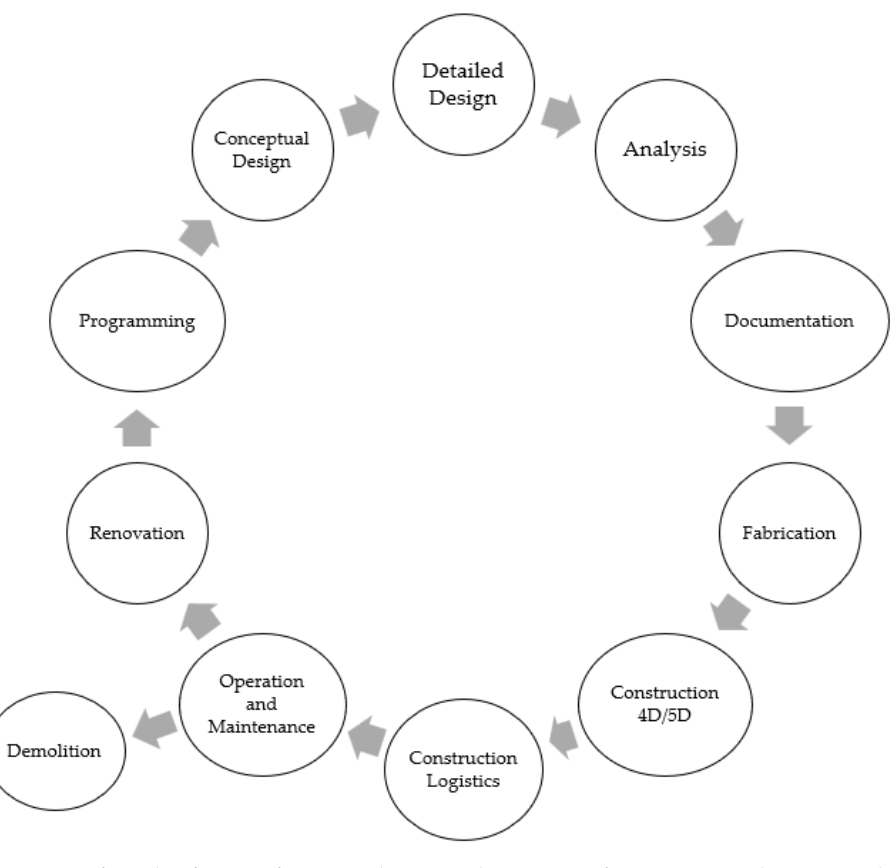
Figure 2. Life cycle of BIM software to showcase the process of generating and managing building data. Image adapted from [25].